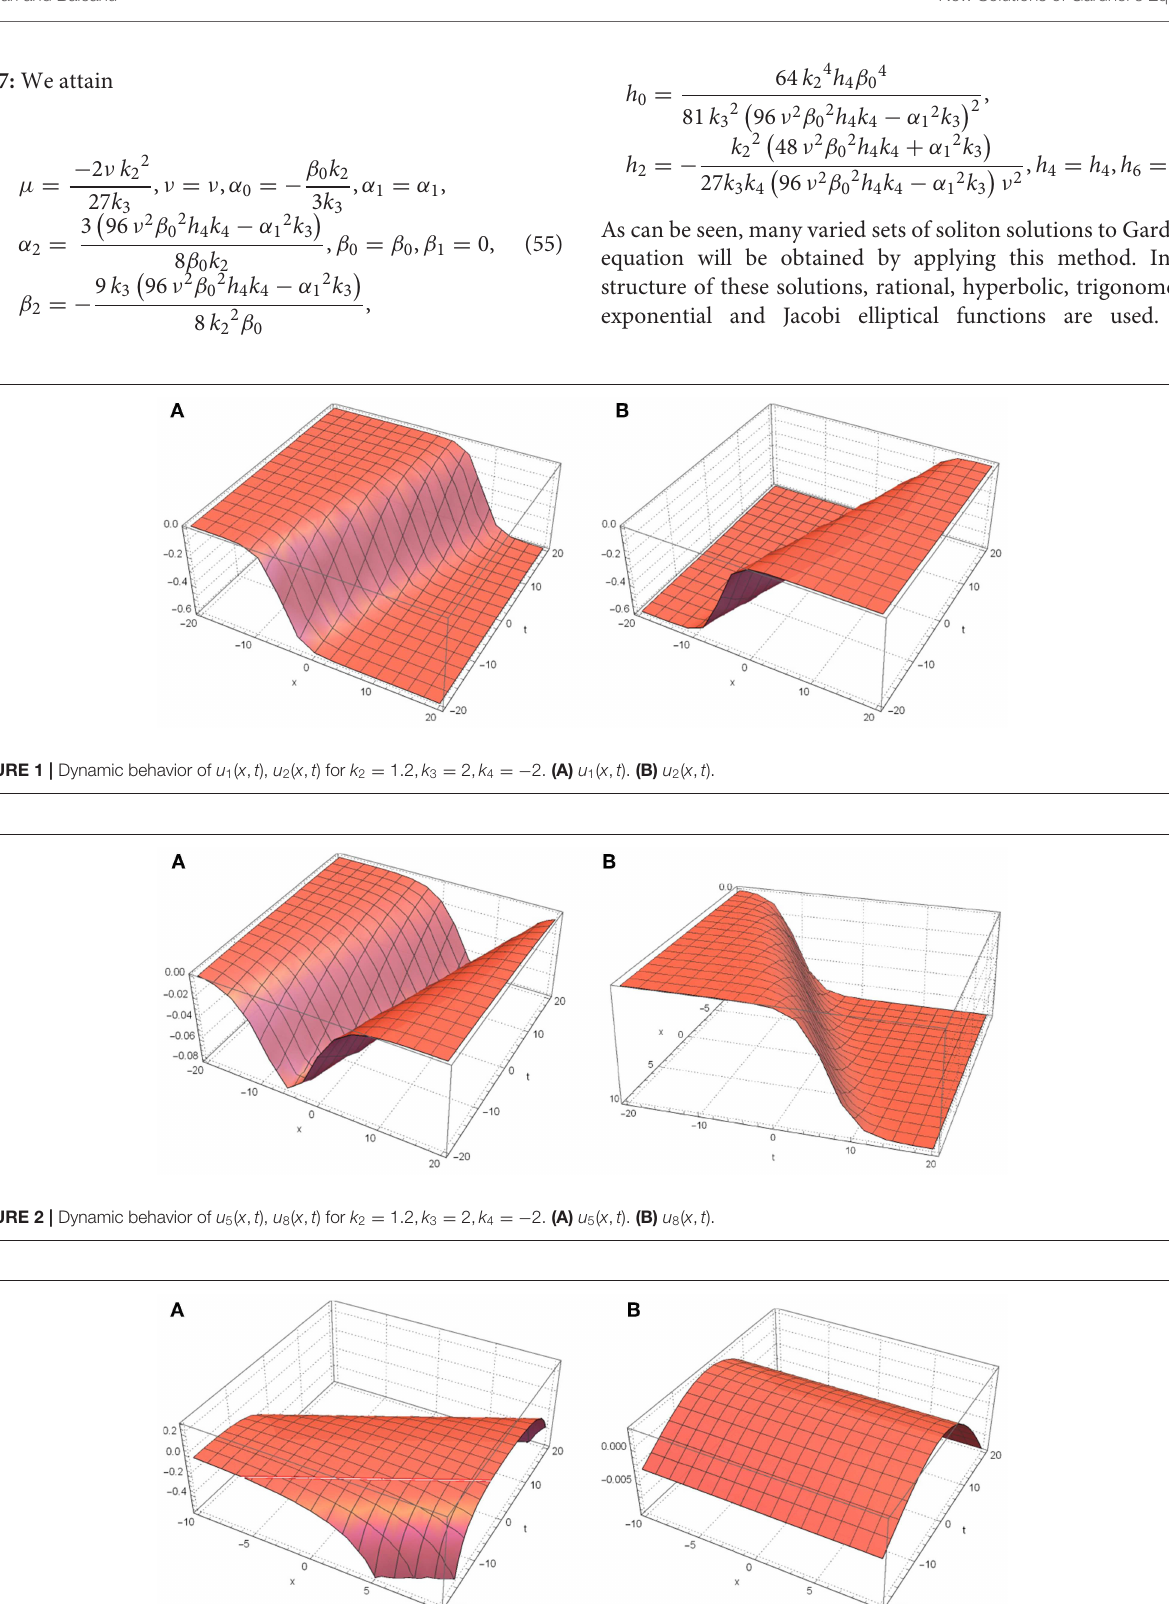
1.1, k 3 1.2, k 4 0.5. (A) u 9 ( x , t ). (B) u 10 ( x , t ). = = − =